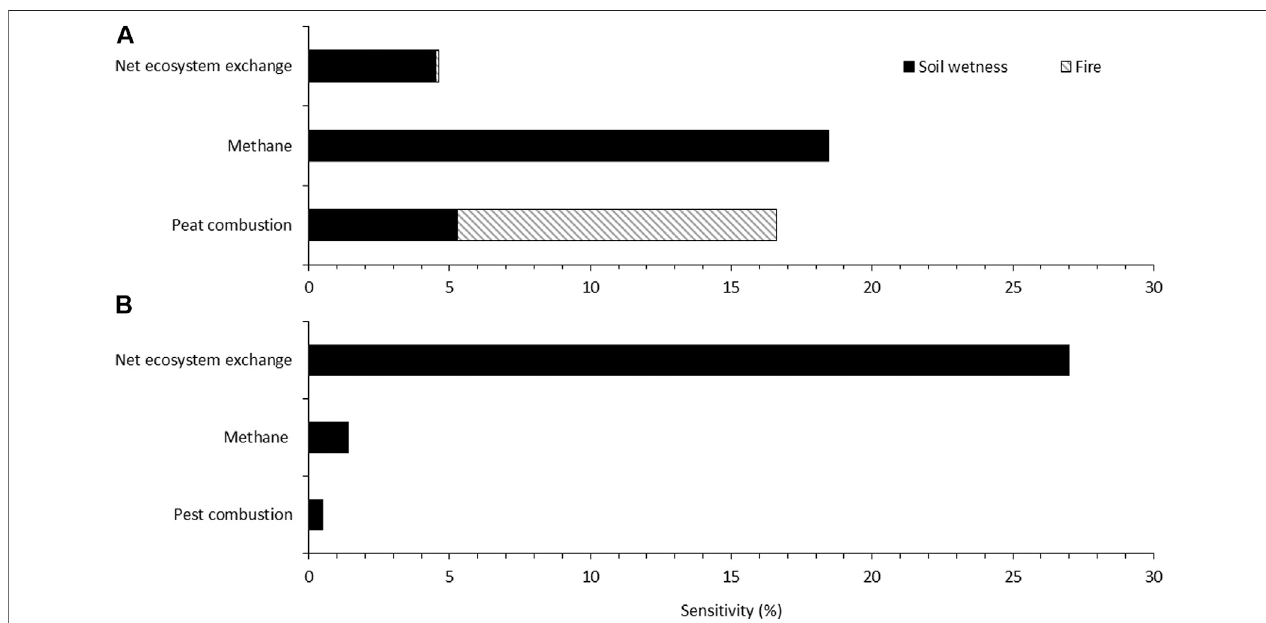
FIGURE 10 | In consideration of current, moderate, and severely warmer scenarios of a landscape containing 43% bogs, 51% fens, and 6% permafrost, (A) sensitivities of net ecosystem exchange, methane emissions, and peat combustion to soil wetness and fi re and (B) sensitivity of the net peat carbon balance to net ecosystem exchange, methane emissions, and peat